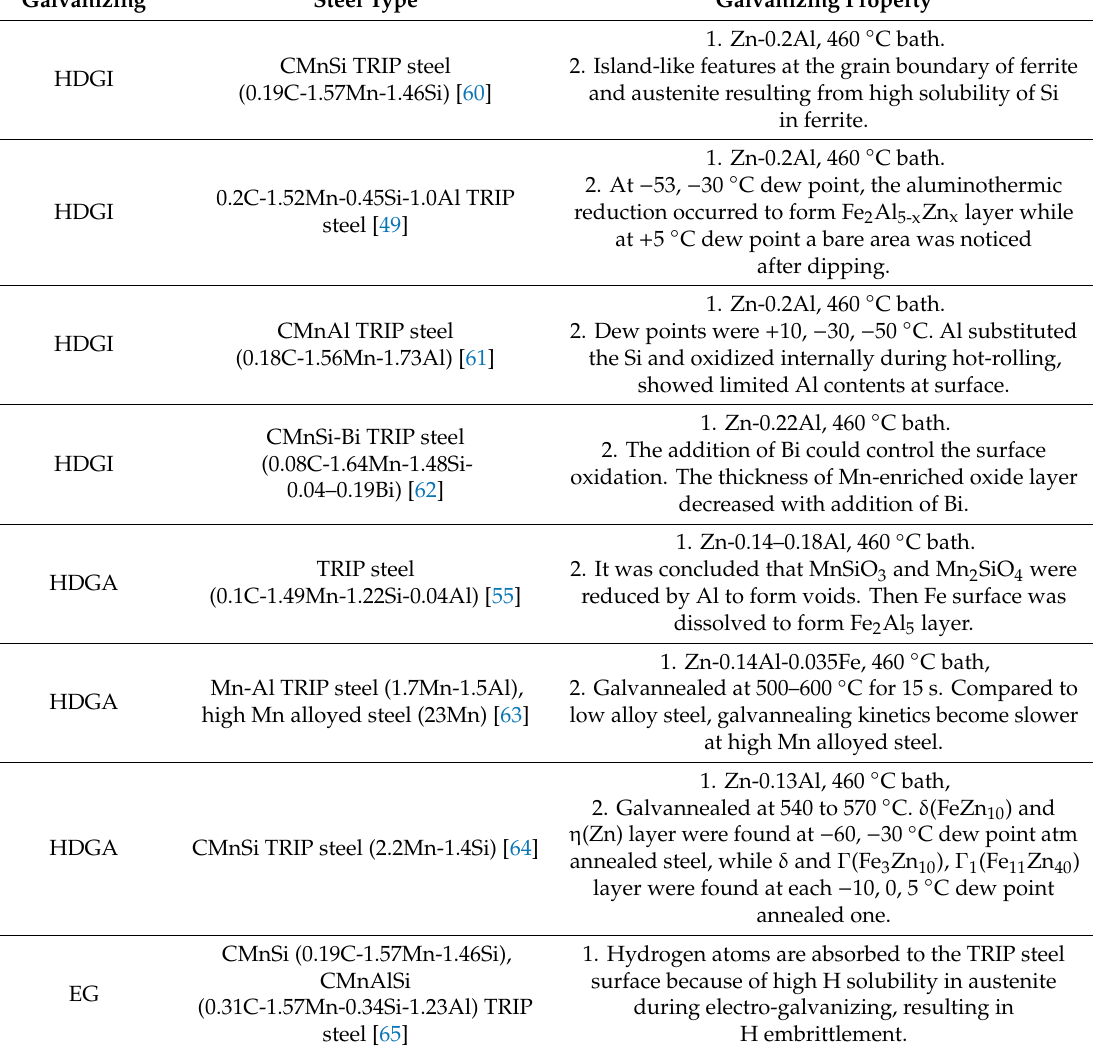
Table 2. Classification of process, steel and properties of galvanizing steels.